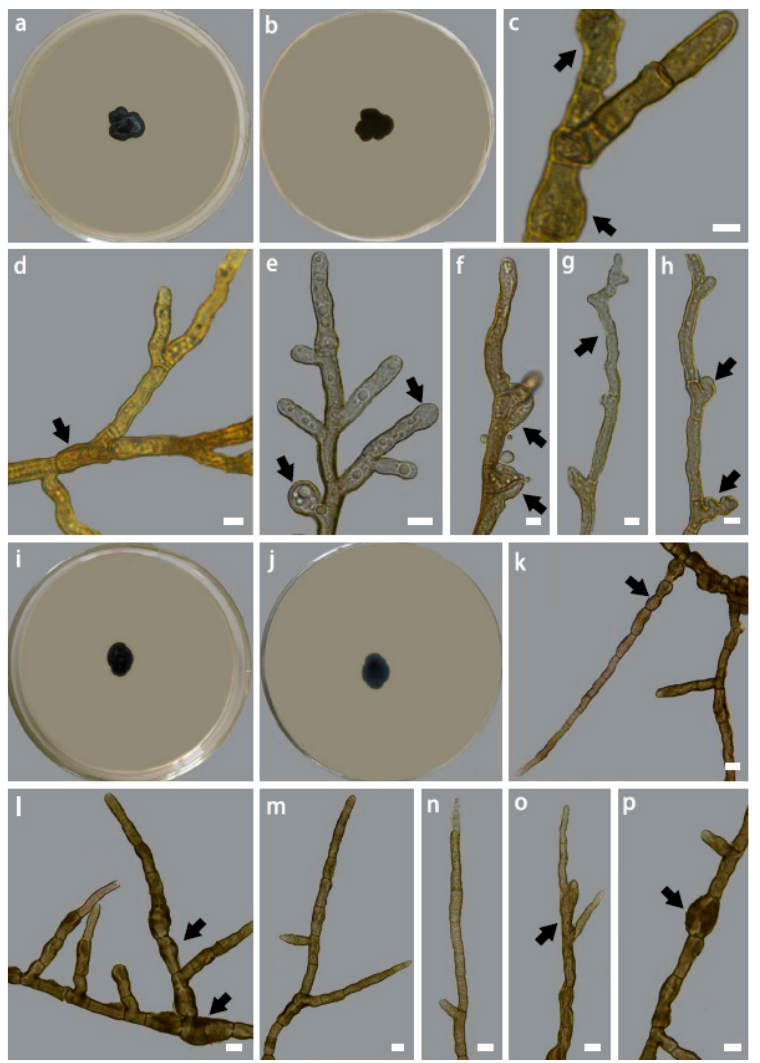
Figure 4. Colony morphology of Intumescentia tinctorum sp. nov. (CGMCC3.23634) on PDA medium after 30 days at 25 °C, ( a ) top, ( b ) reverse, hyphal morphology ( c – e ) branched hyphae with interca- lary swelling, ( e ) apical hyphal swelling, ( f ) lateral branch emerging from swollen and distorted hyphal swelling, ( g ) slightly curved juvenile hyphae with distorted apex; ( h ) distorted lateral branching; colony morphology of Intumescentia vitii sp. nov. (CGMCC3.23741) on PDA medium af- ter 30 days at 25 °C, ( i ) top, ( j ) reverse, hyphal morphology ( k ) peanut-shaped compartments, ( l – p ) a variety of swollen and distorted compartments with branches emerging from the base of septa. Bars = 5 μ m. Morphological structures listed above are indicated with arrows.